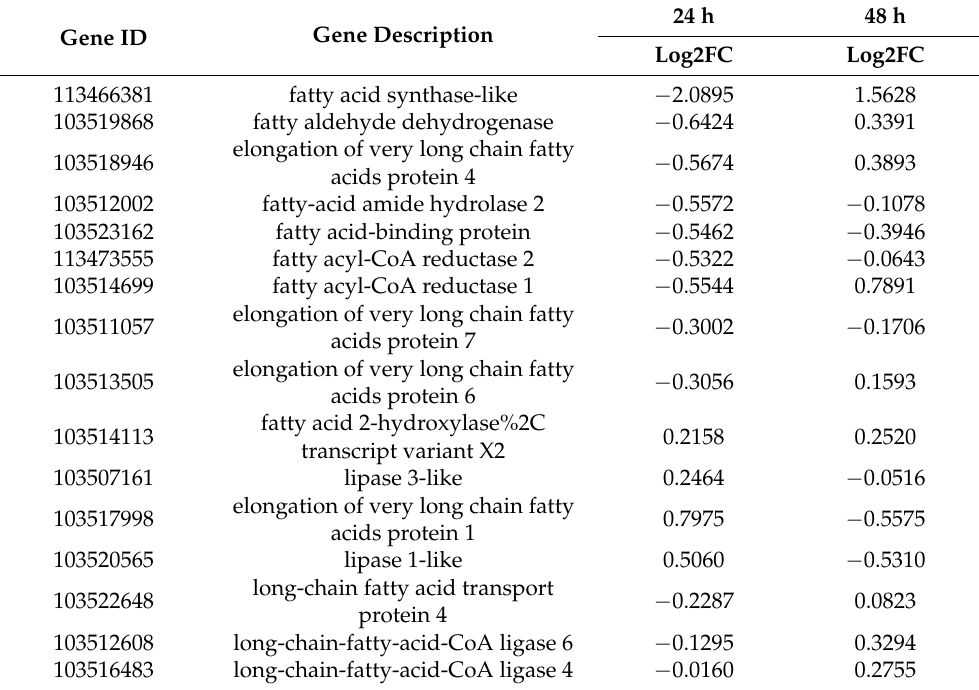
Table 2. Identification of DEGs associated with fatty acid metabolism in different comparable